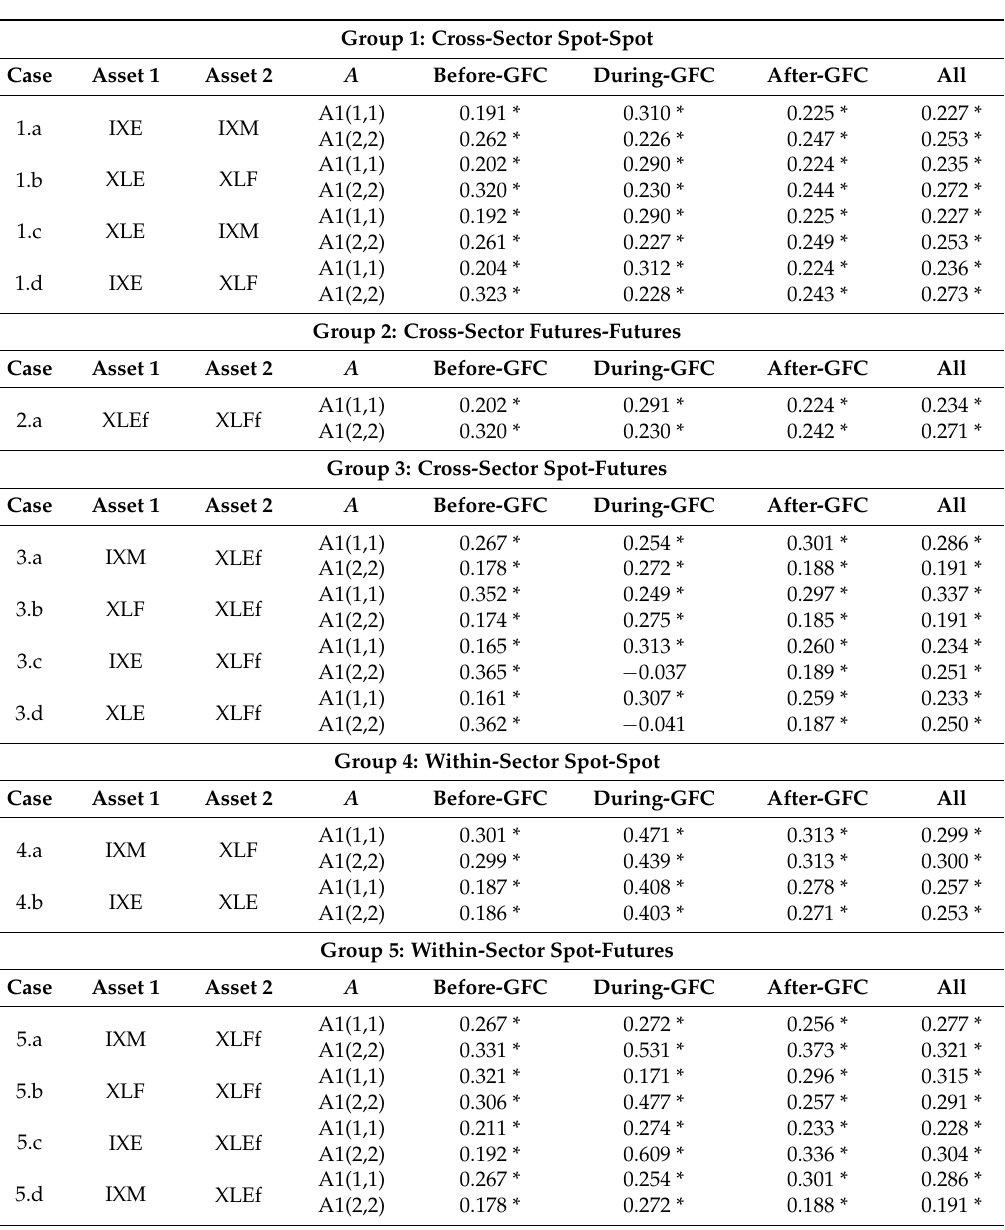
Table 4. Estimation of diagonal elements of A in BEKK. GFC, Global Financial